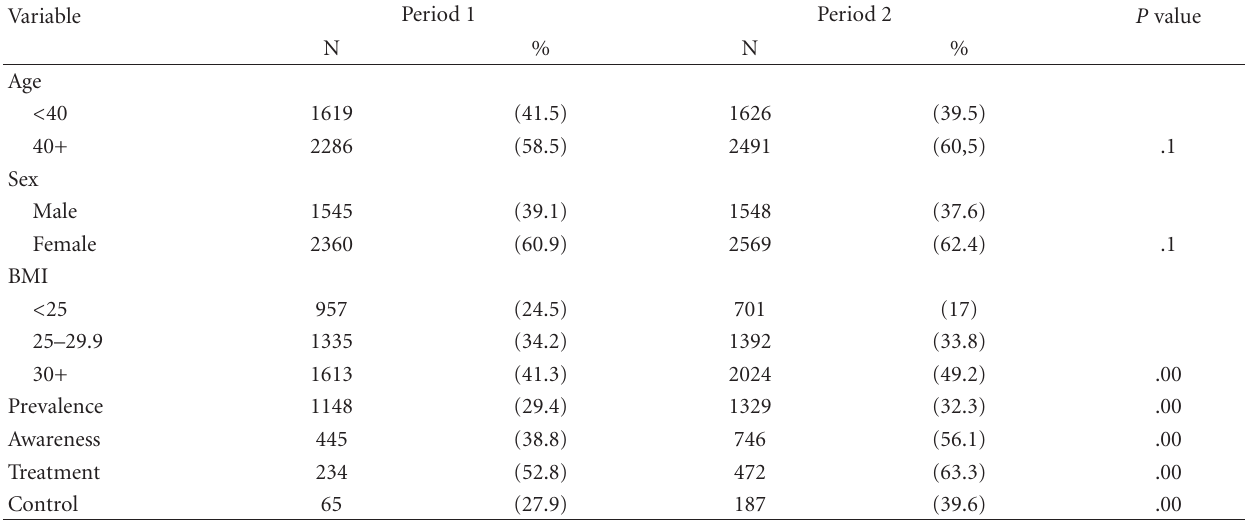
Table 4: Distribution of prevalence, awareness, treatment and control of hypertension, and sociodemographic characteristics of participants by study